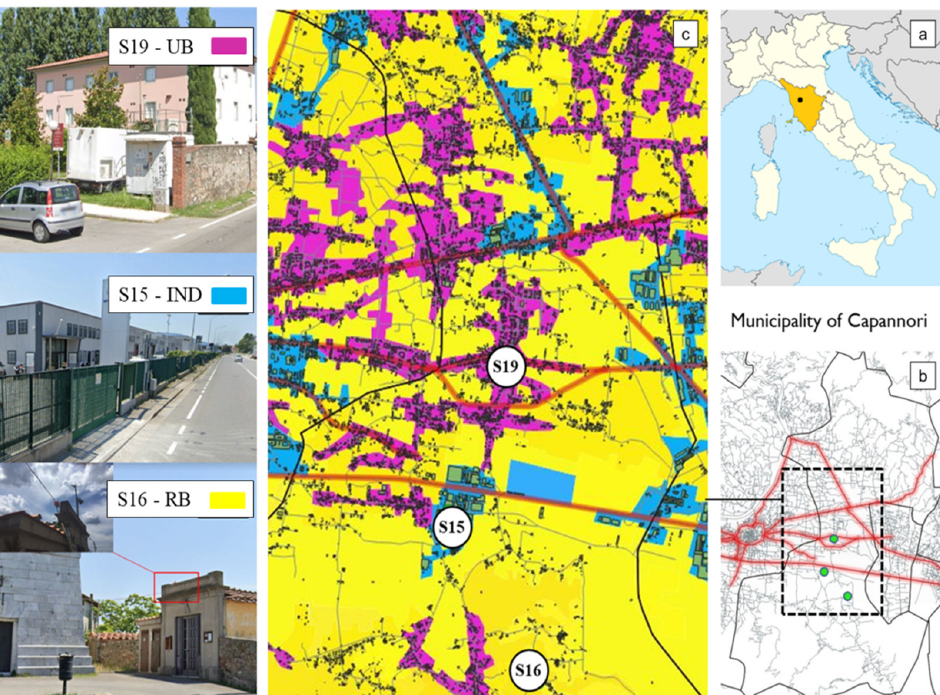
Figure 1. Integrated composition of the monitoring area showing: ( a ) location of the municipality of Capannori within the Tuscany region; ( b ) location of the three AirQino stations (S15, S16 and S19) and ARPAT station (co-located with S19); ( c ) air pollution areas identified within the study area. The pictures of each AirQino station and the area of deployment are also shown.